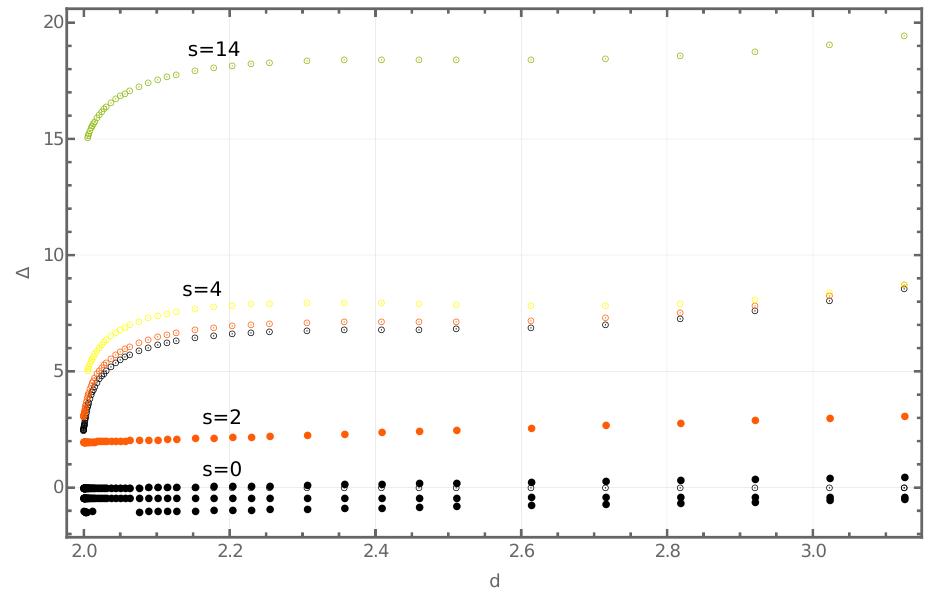
Figure 8 . Roots of the extremal functional for increasing spacetime dimension d. Single roots are denoted by filled circles and double roots are denoted by dotted